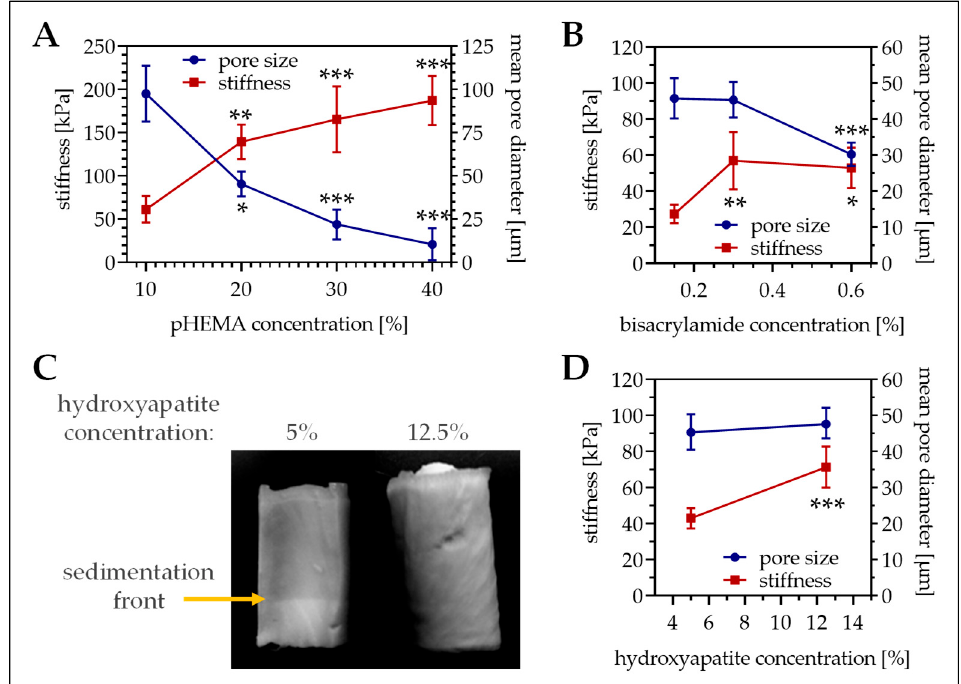
Figure 1. Pore size and stiffness of cryogels with different composition. ( A ) Variation of the pHEMA concentrations (10%, 20%, 30%, and 40% pHEMA with constant bisacrylamide ratio) in cryogels containing 5% hydroxyapatite. ( B ) Variation of the bisacrylamide concentration in 16% pHEMA cryogels containing 5% hydroxyapatite. ( C , D ) Variation of the hydroxyapatite concentration in 16% pHEMA (0.3% bisacrylamide) cryogels. ( C ) Representative photograph of the cryogel. ( A , B , D ) In the graphics pore diameter is represented with the blue line (right scale) and cryogel stiffness is represented with the red line (left scale). Single data points represent mean ± 95% C.I. * p < 0.05, ** p < 0.01, and *** p < 0.001 when compared to the lowest concentration presented.